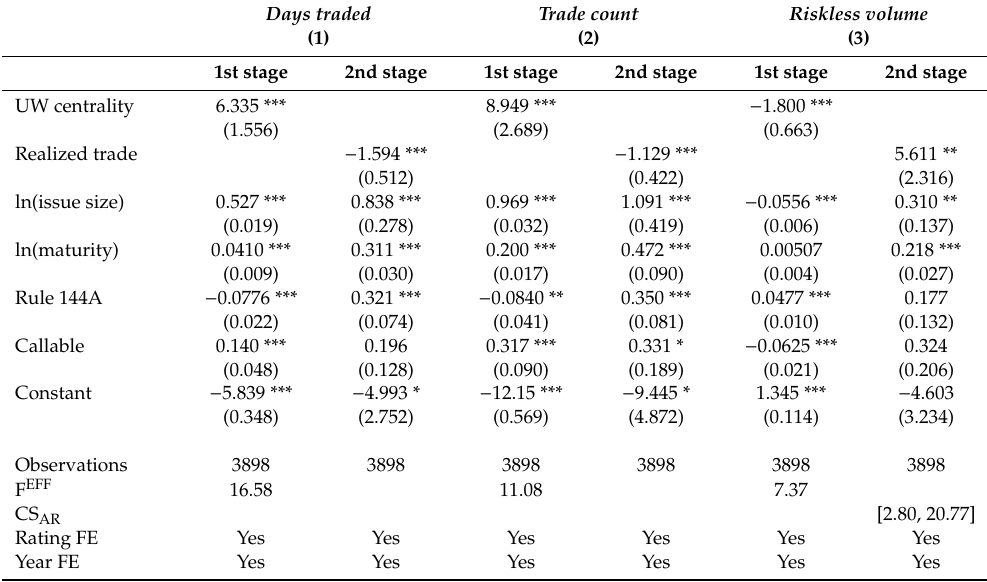
Table 5. V Regressions for O ff ering Yield Spread: Investment Grade